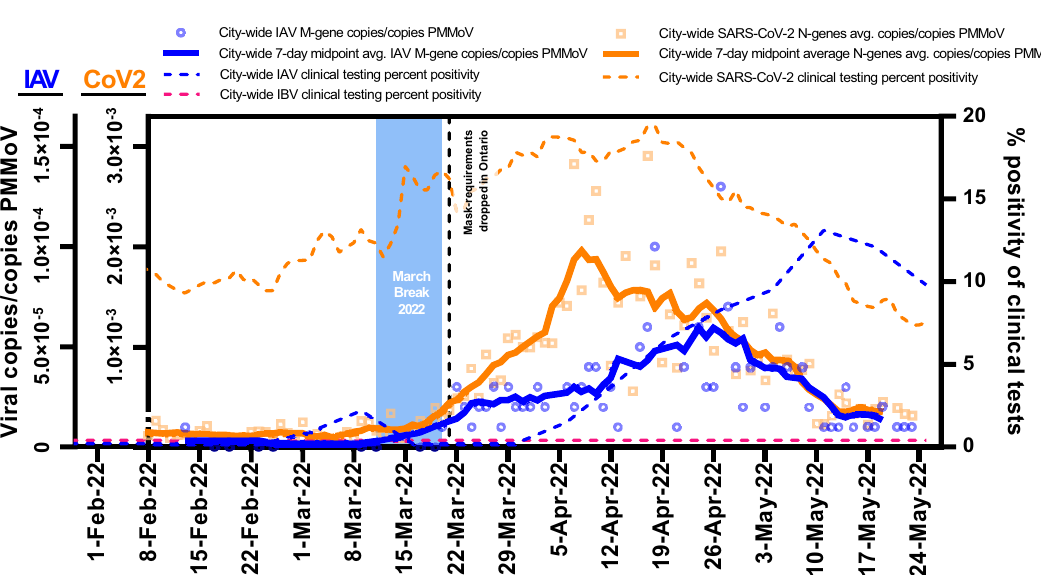
Figure 2. A comparison of both IAV and SARS-CoV-2 wastewater signals citywide in Ottawa, from samples harvested from the city’s WRRF. It was demonstrated that the detection of IAV in wastewater at the city-level (Feb. 13, 2022) occurred 17 days before the first clinical detection of IAV at any of the city’s hospitals or